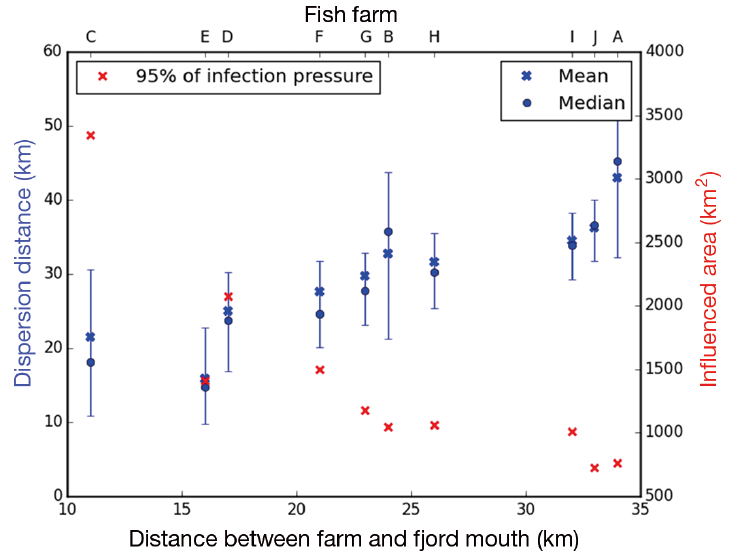
Fig. 12. Connectivity matrix of simulated salmon lice Lepeophtheirus salmonis infestation between fish farms in the Folda fjord system between 1 April and 31 August